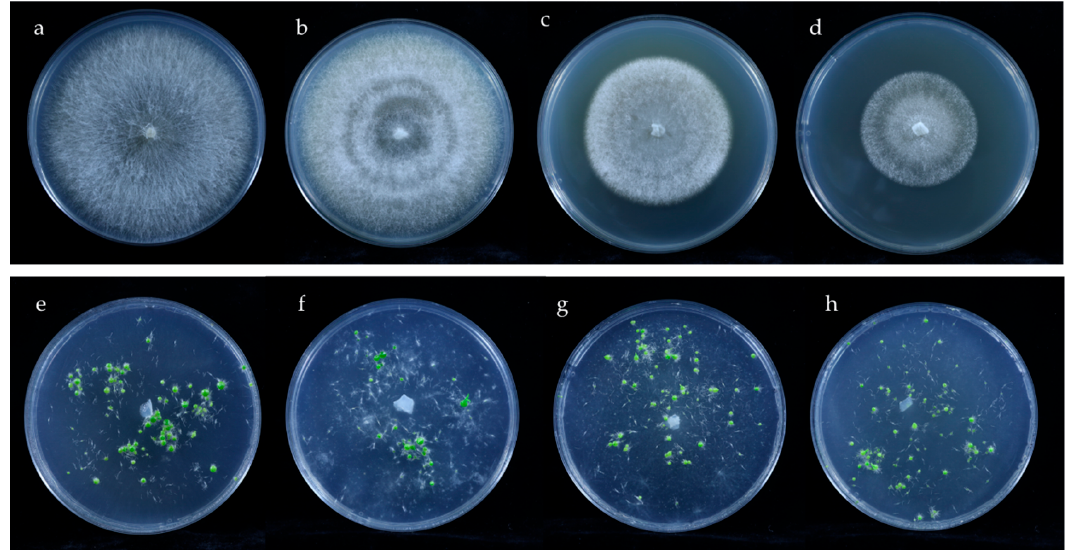
Figure 4. Colony morphology and in vitro symbiotic germination of E. radicans with germination- enhancing fungi in 90 mm Petri dishes: ( a – d ) colony morphology of Epi128, Epi221, Epi124, and Epi317; ( d – h ) in vitro symbiotic germination of seeds with fungal isolates Epi128, Epi221, Epi124, and Epi317.